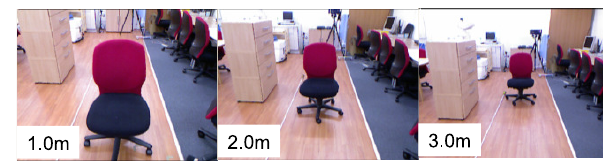
Figure 12: Appearance difference along to distance